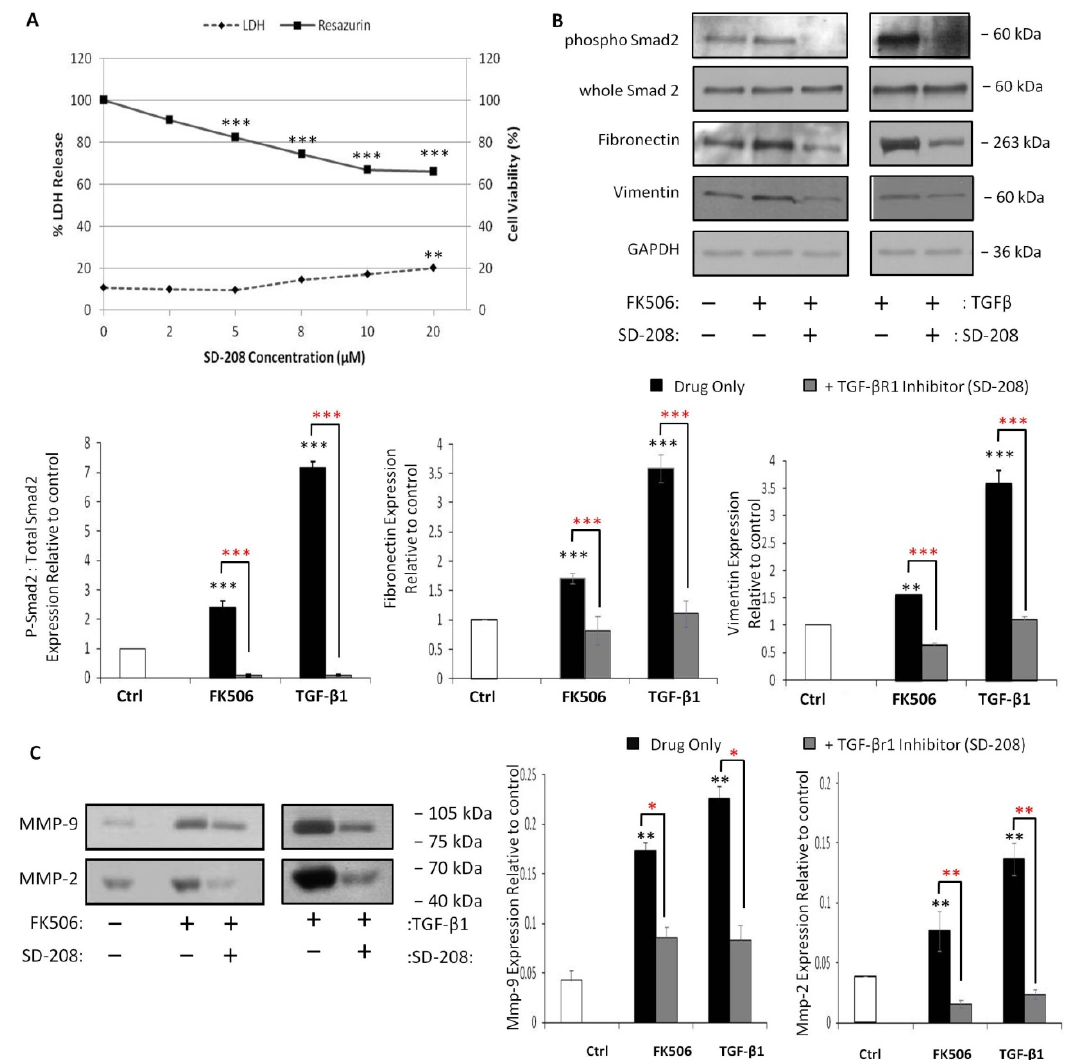
Figure 6. The specific blockade of T β RI kinase ablated Smad2 activation and dramatically affected the induction of the EMT markers, vimentin and MMPs by FK506. HK ‐ 2 cells were cultured on 6 ‐ well plates and treated with vehicle control, 5 μ M FK506 with or without 500 nM of a TGF β RI/ALK5 kinase inhibitor V (SD ‐ 208). ( A ) Cells were incubated for 48 h with SD ‐ 208 concentrations ranging from 0–20 μ M. LDH and resazurin assays were conducted to assess SD ‐ 208 inhibitor toxicity; ( B ) Whole cell protein was extracted at 48 h with RIPA buffer. Equal amounts of protein were separated by SDS ‐ PAGE electrophoresis, transferred to nitrocellulose and indirectly probed for vimentin and fibronectin using a mAb and ECL detection system. Whole Smad2 and GAPDH was used as a loading control. A representative blot is shown from three independent experiments. Densitometry is shown for the replicate blots; ( C ) Cell culture supernatants were harvested, centrifuged to remove cellular debris and concentrated using Amicon Ultra ‐ 4 Centrifugal Filter Devices (Millipore). Gelatin substrate zymography was used to separate and assess MMP ‐ 9 and MMP ‐ 2 activity. Clear areas represent areas of gelatinolytic activity. A representative zymogram is shown from three independent experiments. ** and *** indicates different levels of significant compared to time ‐ matched control; *, ** and *** indicates varying levels of significance compared to treatment + inhibitor.